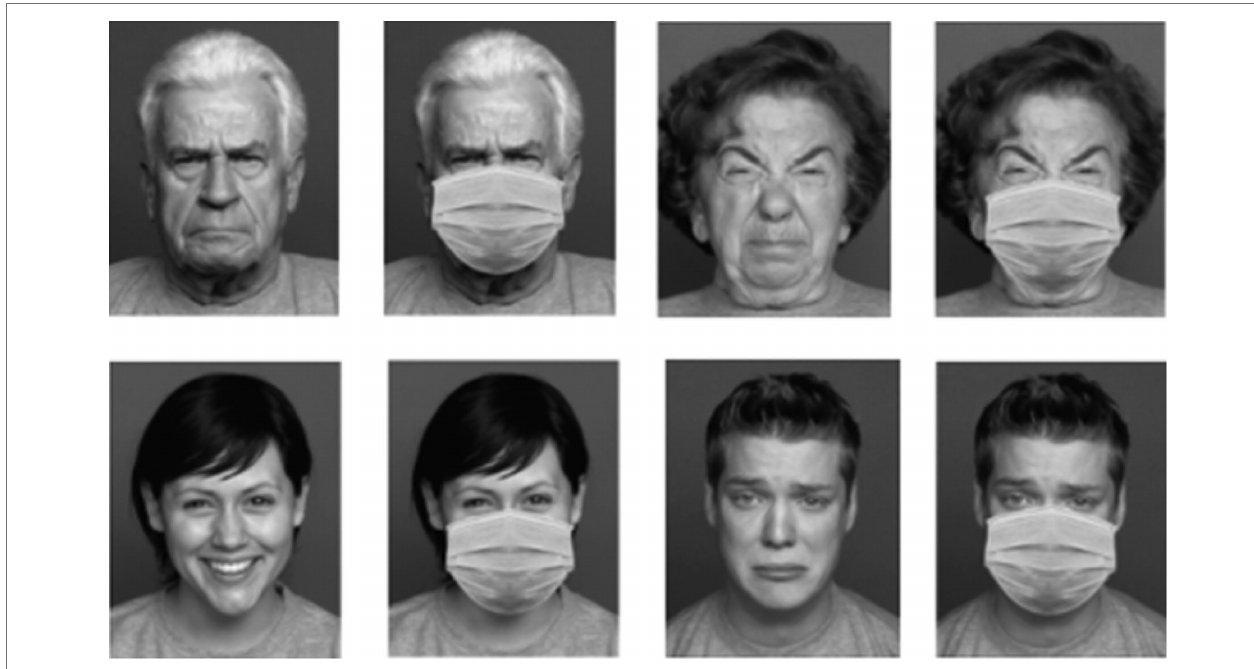
FIGURE 3 | Shown are examples for images used for the emotion-recognition task. Six different emotions were presented with and without a face mask. Pictures here are “anger” (top left), “disgust” (top right), “happy” (bottom left), and “sad” (bottom right). Modified and reproduced with permission from (Max Planck Institute for Human Development, Center for Lifespan Psychology, Berlin, Germany), available at